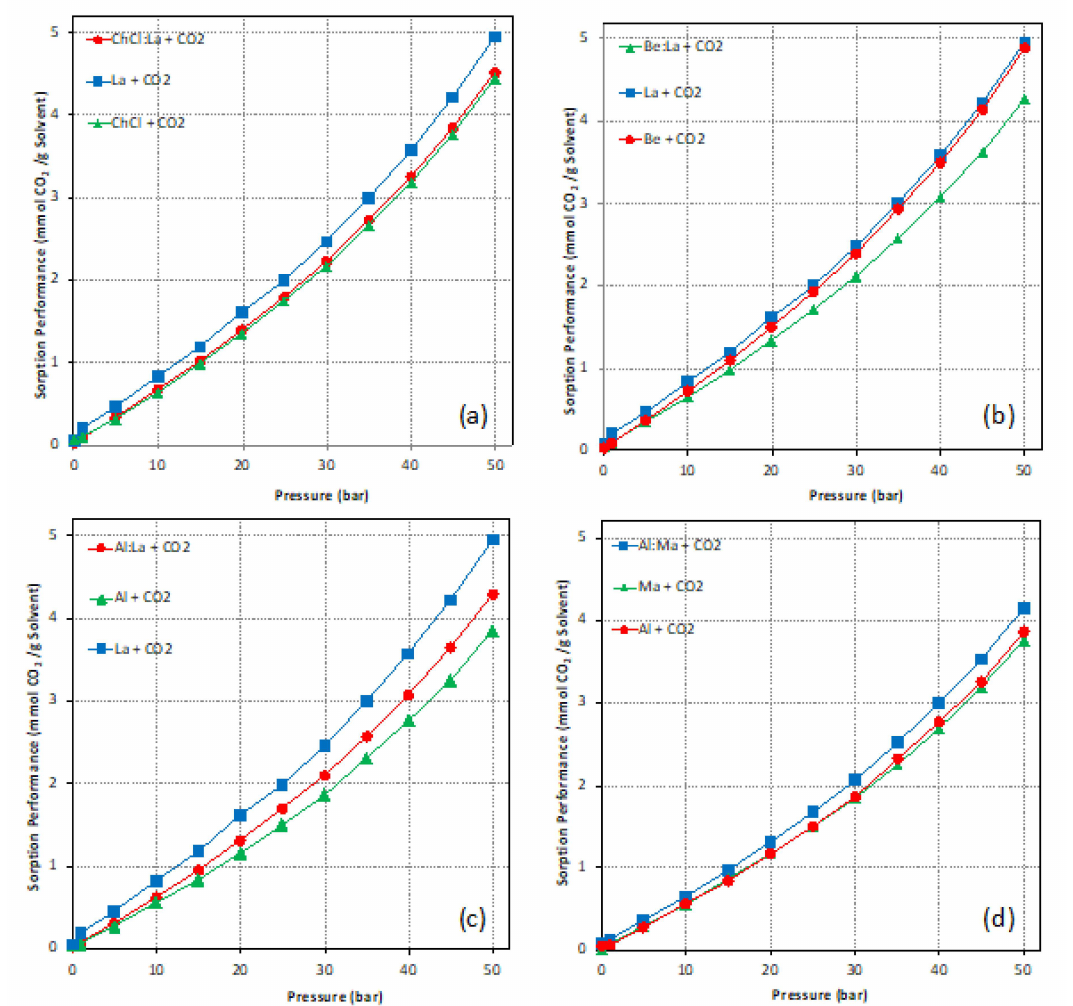
Figure 2. CO 2 capture performance of studied deep eutectic solvents (DES) systems and comparison to their constituents. ( a ) ChCl:La + CO 2 , ( b ) Be:La + CO 2 , ( c ) Al:La + CO 2 , ( d ) Al:Ma + CO 2